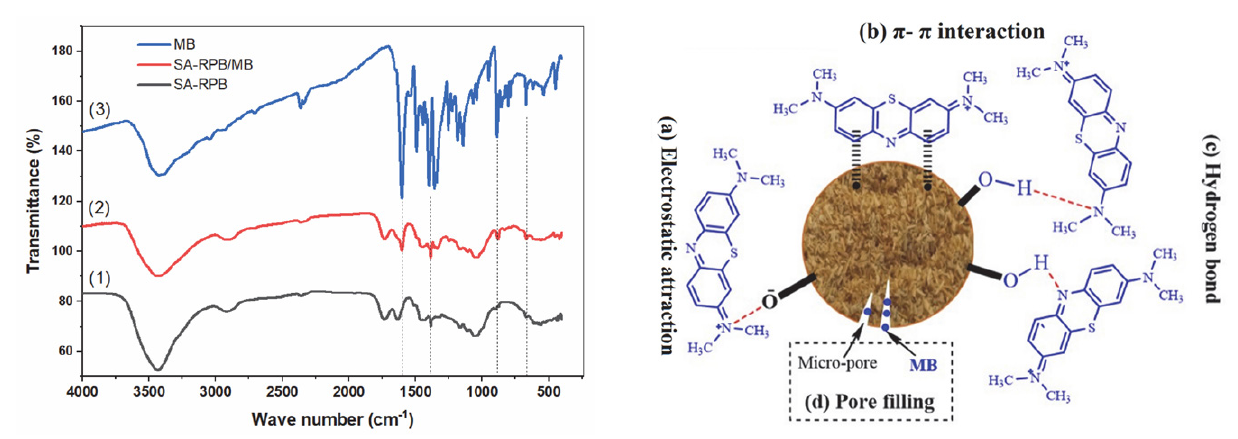
Fig. 11. Possible adsorption mechanism of MB onto SA-RPB